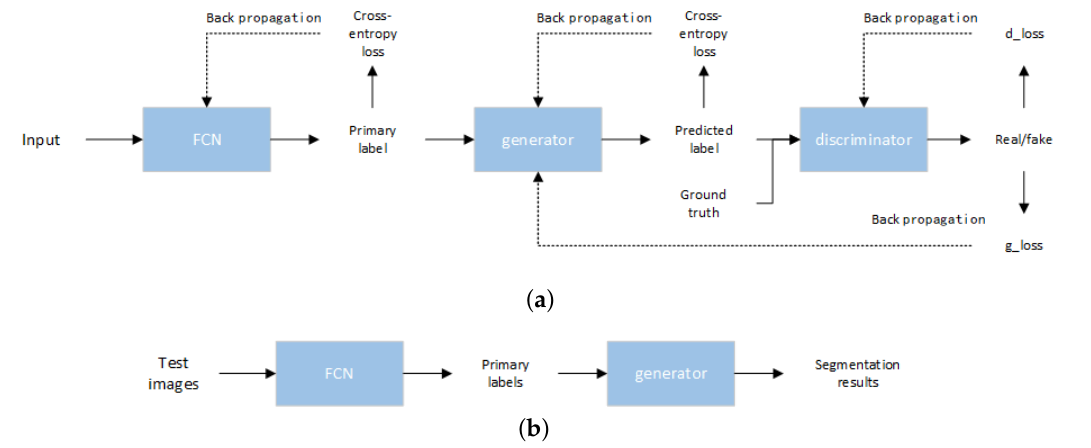
Figure 5. Flowchart of training and testing processes. ( a ) Training process; ( b ) Testing